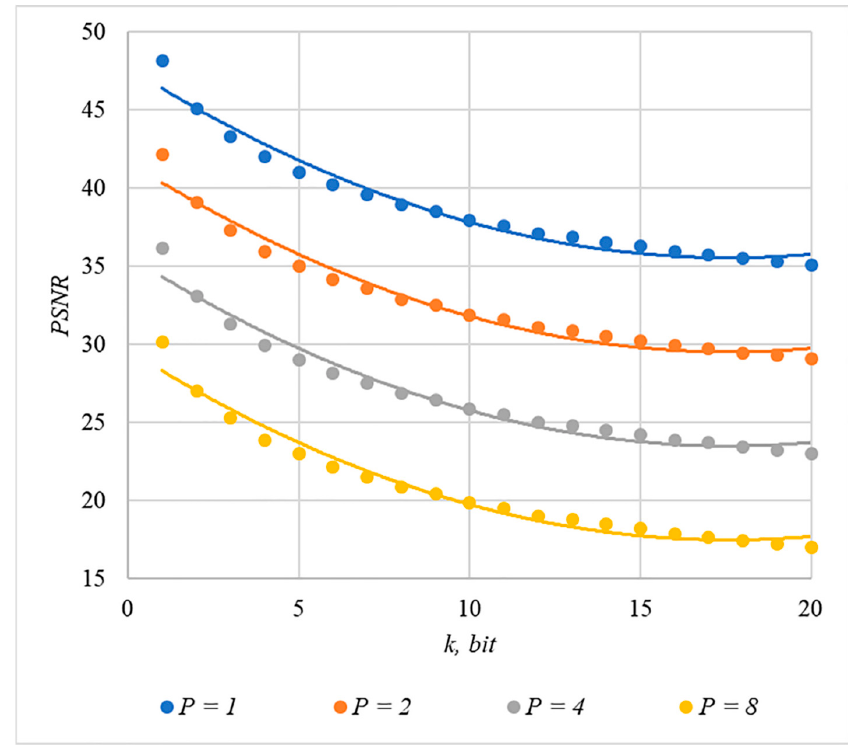
Figure 9. MSE ( k ) dependencies for different values of P rules for generating chip codes № 1, 3, 4, and 5.